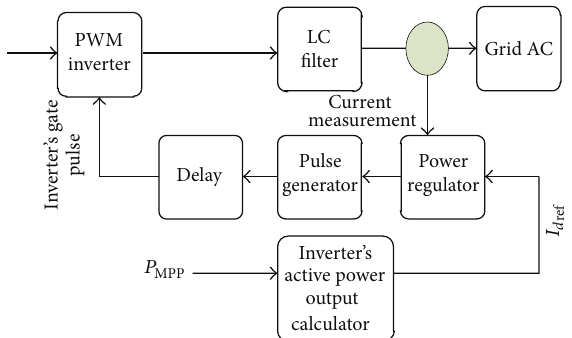
Figure 12: Inverter and its controllers connected to network.